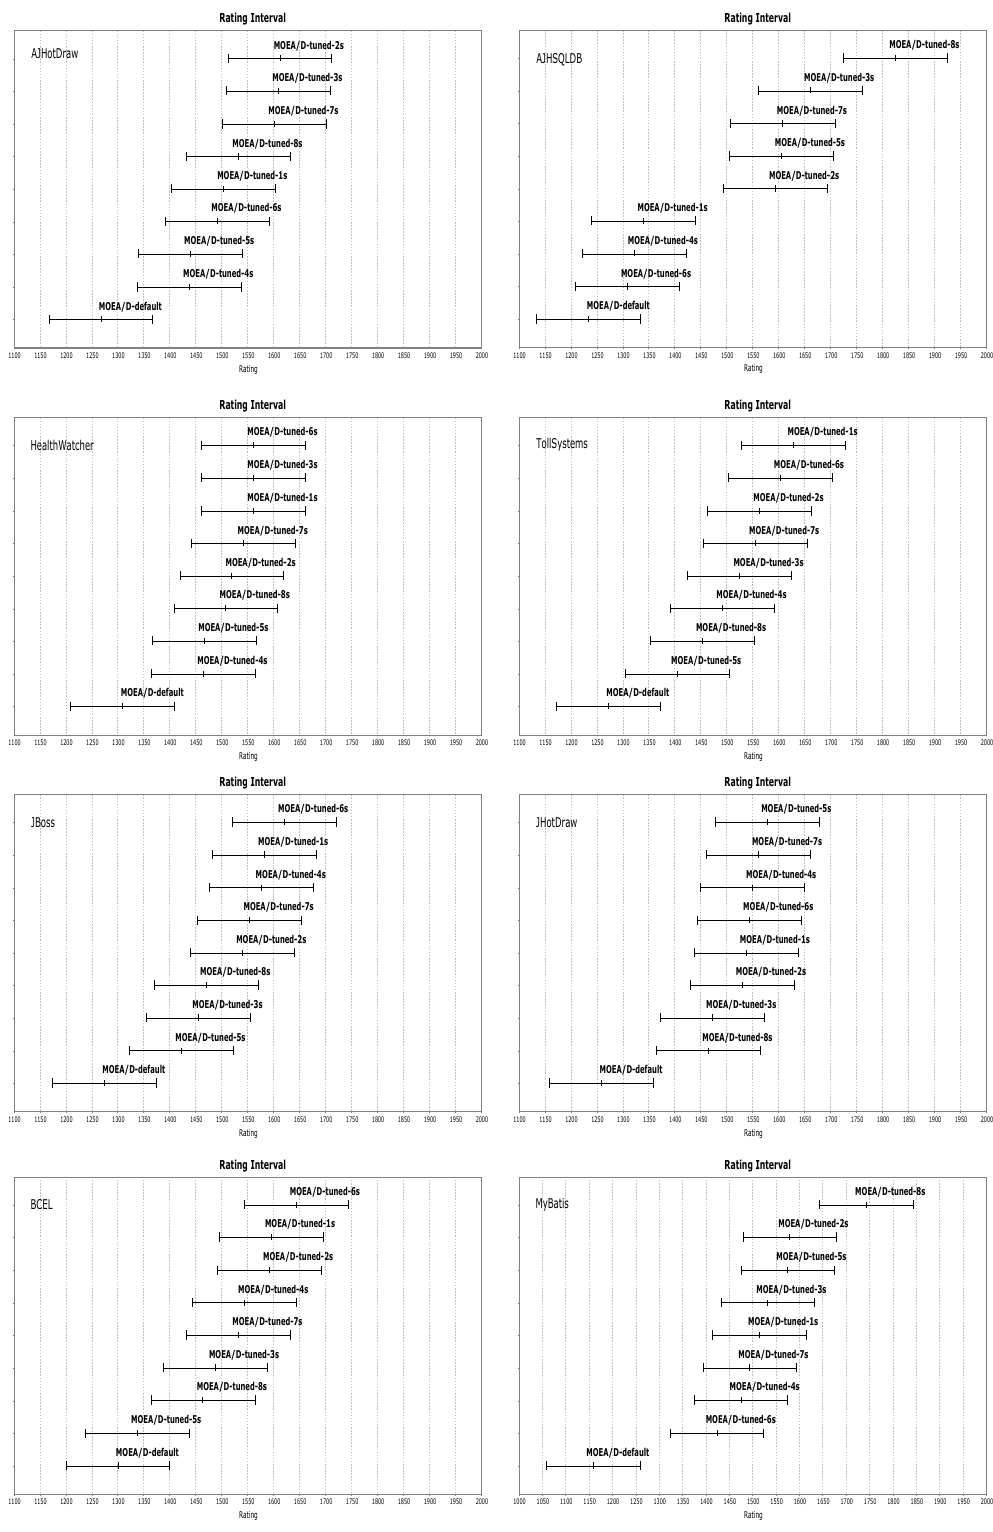
Figure 6. Rating intervals for the best configurations obtained with MOCRS-Tuning on different sized problem set ranked on eight different systems where each configuration is marked from 1 s to 8 s, which indicates the number of systems used in the tuning